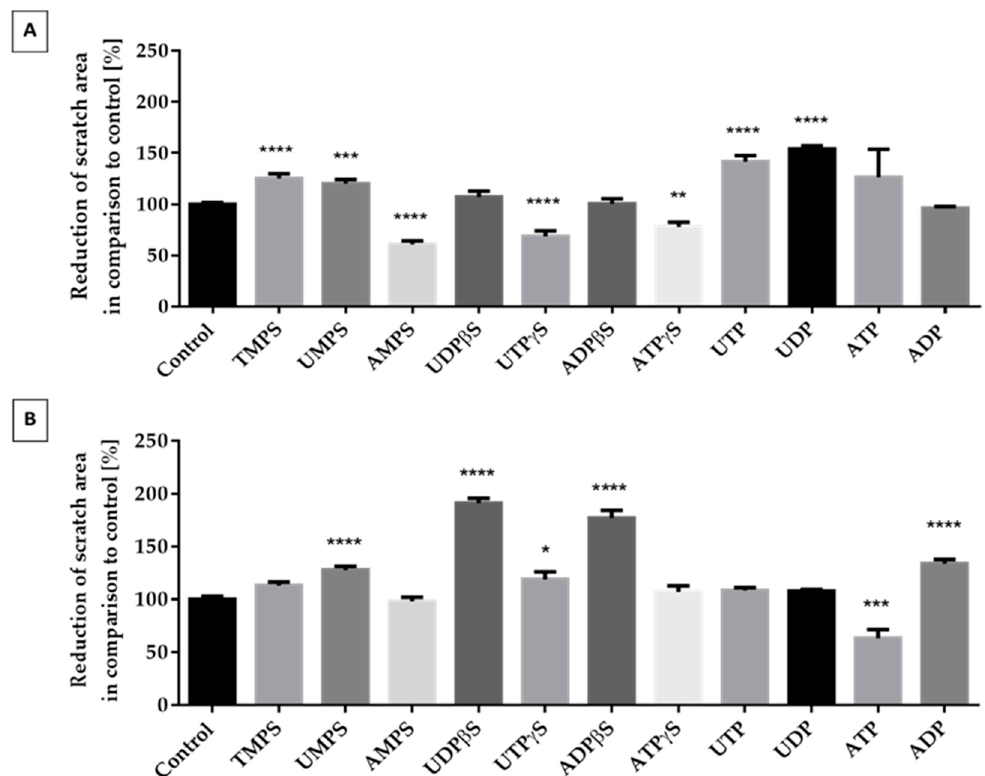
Figure 3. The effect of unmodified nucleotides and their phosphorothioate analogs on the migration of ATDC5 cells grown for 48 h in starving medium ( A ) or in differentiation medium ( B ). The extent of migration was documented with the Leica 205C microscope and processed in Leica Application Suite. Results represent a percentage of wound reduction in comparison to unstimulated control cells. Data represent the means ± SEM from at least six independent experiments. p < 0.01 (**), p < 0.001 (***), and p < 0.0001 (****) for reduction of scratch area significantly different from untreated control cells.